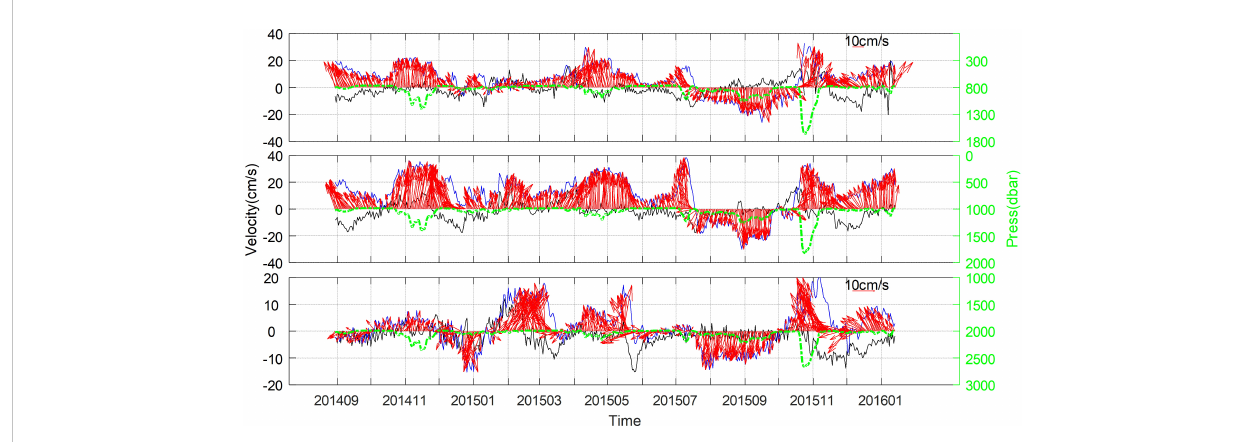
FIGURE 3 Time series of daily averaged zonal (black line) and meridional (blue line) velocity and fl ow vector (red line) at 127°E/8°E by (A) ADCPs at 800 m, and Aqds-6000 current meters at (B) 1000 m, and (C) 2000 m from August 2014 to January 2016 (units are cm s-1).